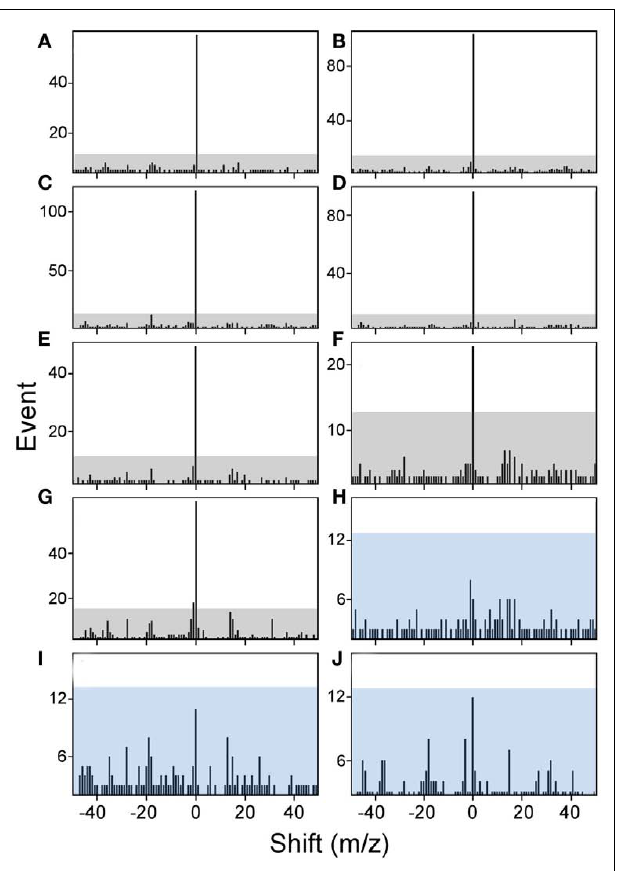
FIGURE 4 | Poisson detection for the E7 11–19 ion fragmentYMLDLQ- in MS 3 555.3/764.4 spectra of HLA-A ∗ 02 bound peptides from biopsied tumor samples. Shaded regions mark a significance boundary set at 4 times the average amplitude excluding the 0-peak. Poisson fits to the unshifted reference spectrum (the 0-peak on the x -axis) that remain within the shaded region do not represent significantly ion events in the MS 3 spectra of the samples. KTS1–KTS9 (A–I) , respectively. Biopsied cervical tumors with the (A–G) representing tumors samples KTS1–7 indicating positive detection. (H,I) Represent negative detection on tumors samples KTS8 and 9. (J) Illustrates peptides from a non-HPV-transformedT cell line, as a negative control. Results are from single immunoprecipitation experiments repeated on nine different tumor samples.